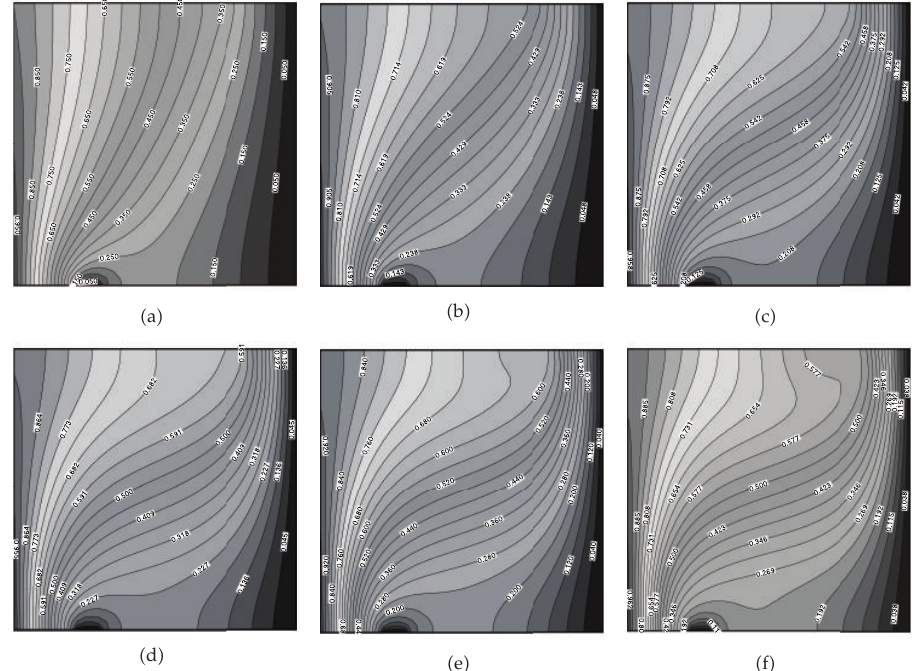
Figure 22: Isoconcentration contours along the left vertical wall while fixing B (cid:8) 1, (cid:2) D/H (cid:3) (cid:8) 0 . 1, a (cid:8) 0 . 1, Ra (cid:8) 100, S C (cid:8) 0 . 1 for (cid:2) a (cid:3) Ra (cid:8) 10, (cid:2) b (cid:3) Ra (cid:8) 25, (cid:2) c (cid:3) Ra (cid:8) 50, (cid:2) d (cid:3) Ra (cid:8) 75, (cid:2) e (cid:3) Ra (cid:8) 100, (cid:2) f (cid:3) Ra (cid:8)